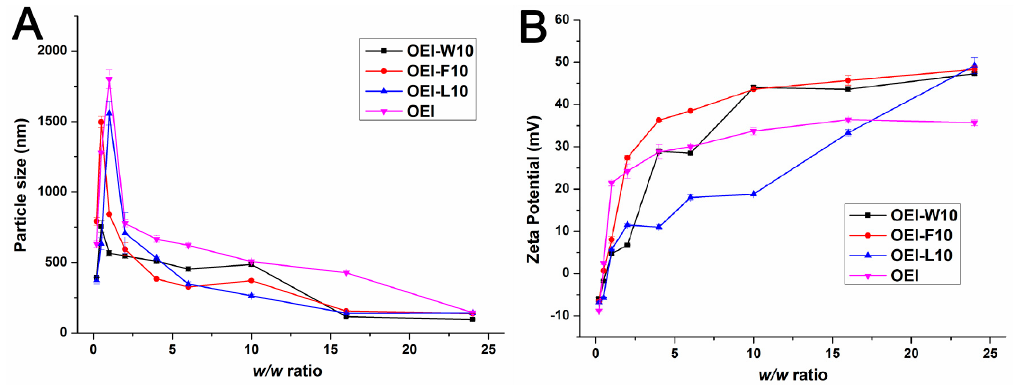
Figure 3. Particle size ( A ) and zeta potential ( B ) of polyplexes obtained at different weight ratios by DLS. Data represent mean ± SD ( n = 3).